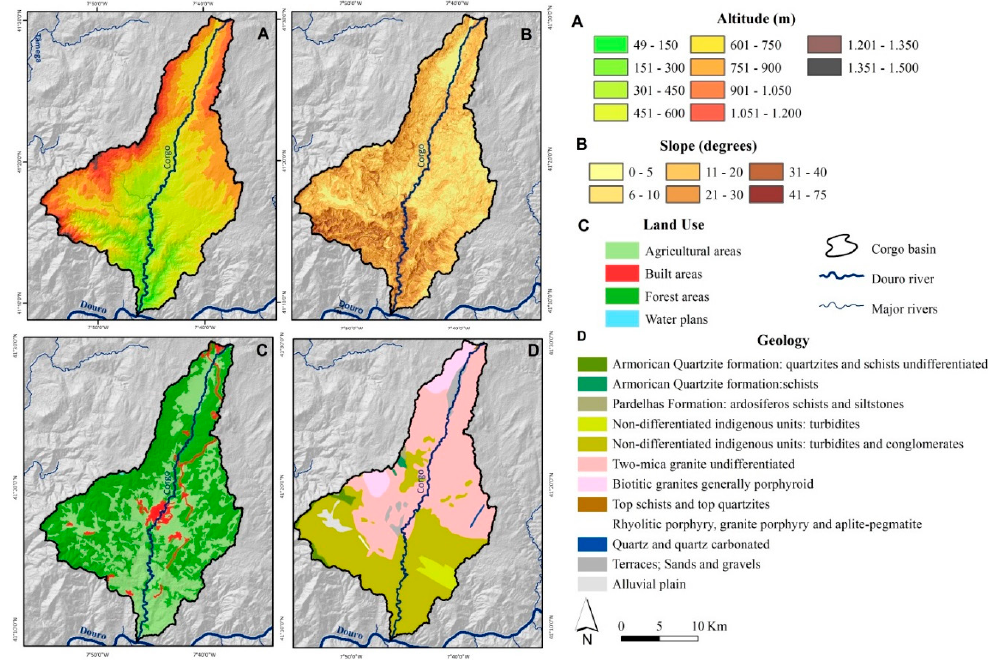
Figure 2. Geographical features of the Corgo basin. ( A ) Altitude; ( B ) Slope; ( C ) Land Use (Corine Land Cover, 2006); ( D ) Geology.